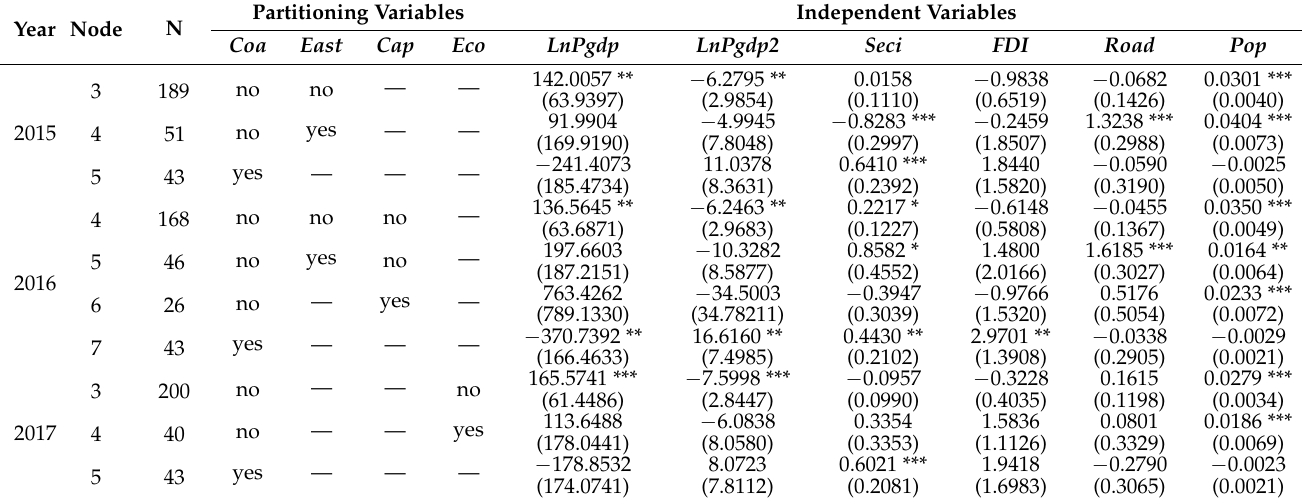
Table 5. Results of a recursive analysis of air pollution influences for the period